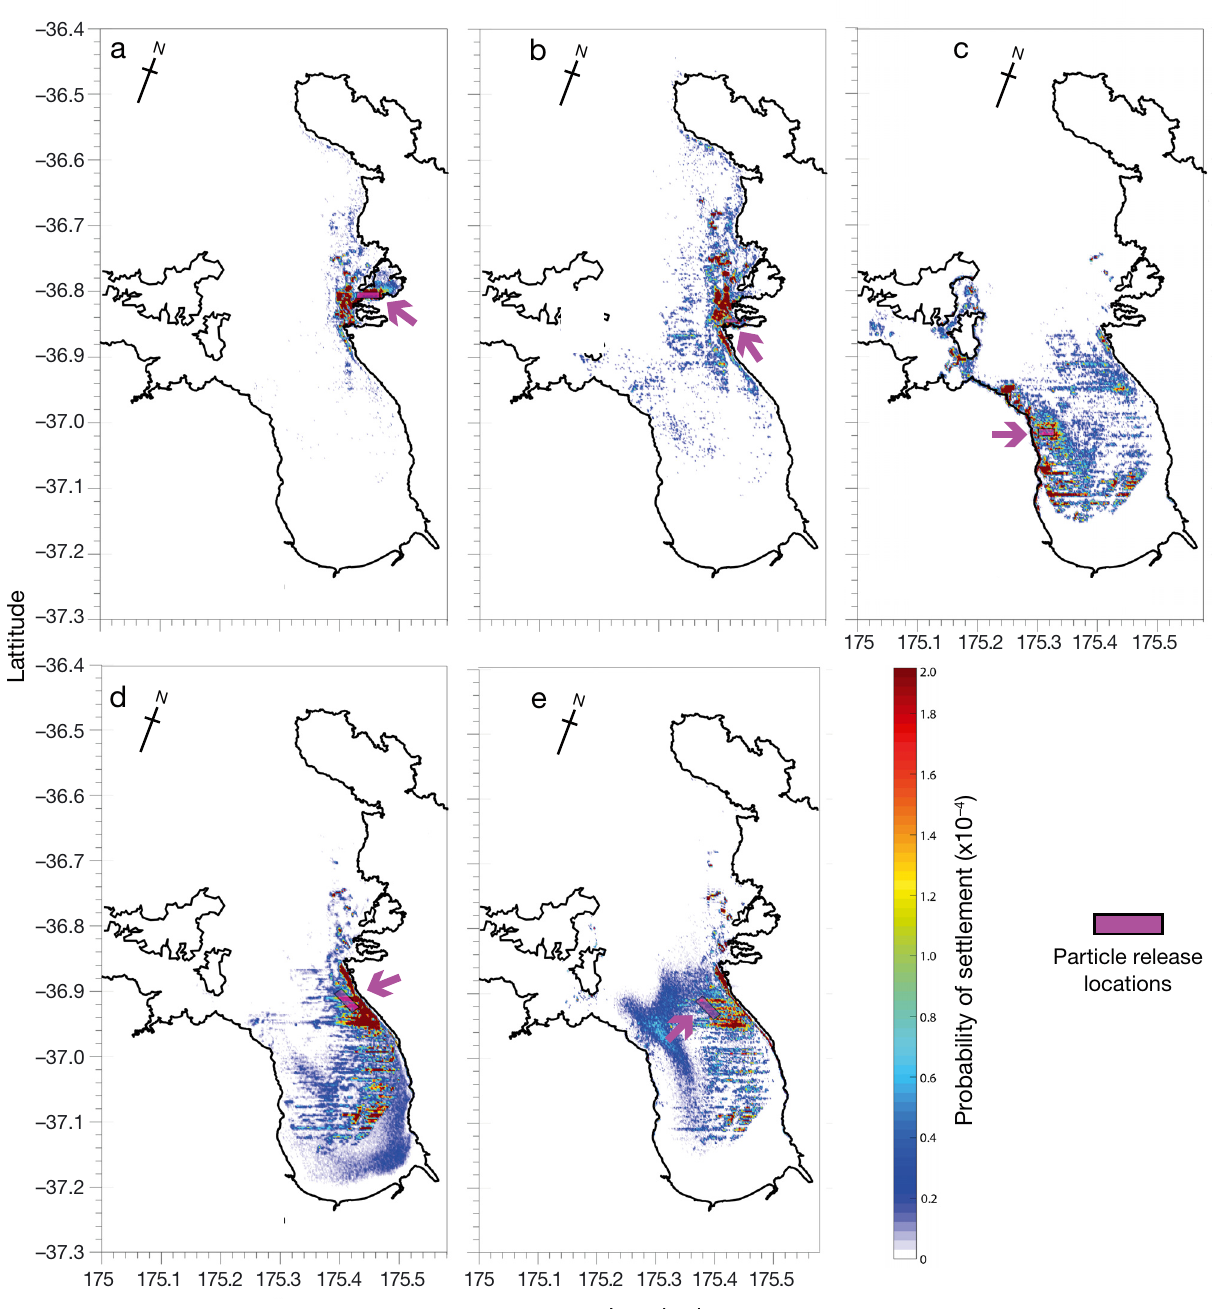
Fig. 4. Site-specific kernel density estimates of settled Perna canaliculus particles released from (a) COR, (b) MAN, (c) WP, (d) WB1, and (e) WB2. All settled particles released over the December−June release window during the entire 11 yr period are shown. Colour scale: portion of particles that settled at each location relative to the total number of particles released from that site. Arrows: locations of particle release